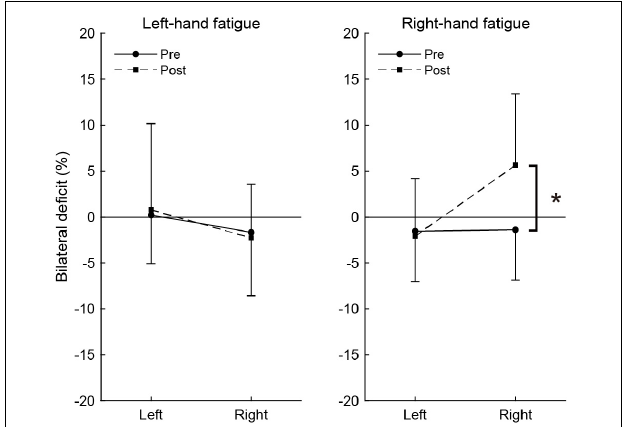
FIGURE 3 | Bilateral deficit in handgrip force. Negative values indicate lower bimanual handgrip force compared with unimanual handgrip force, and positive values indicate higher bimanual handgrip force compared with unimanual handgrip force. Circles and linear lines indicate the values at pre-test, and squares and dashed lines indicate the values at post-test. Data are presented as mean ± SD. * p <